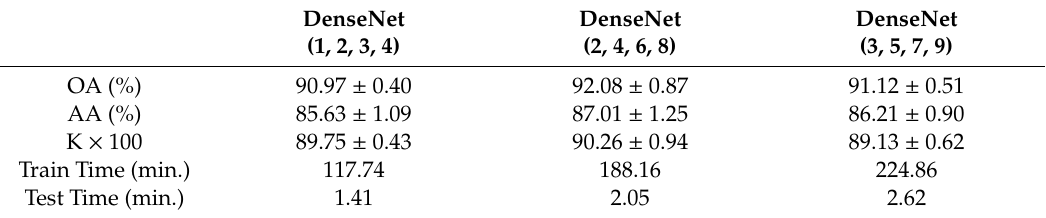
Table 7. Test accuracy of DenseNet over di ff erent depth in Indian Pines